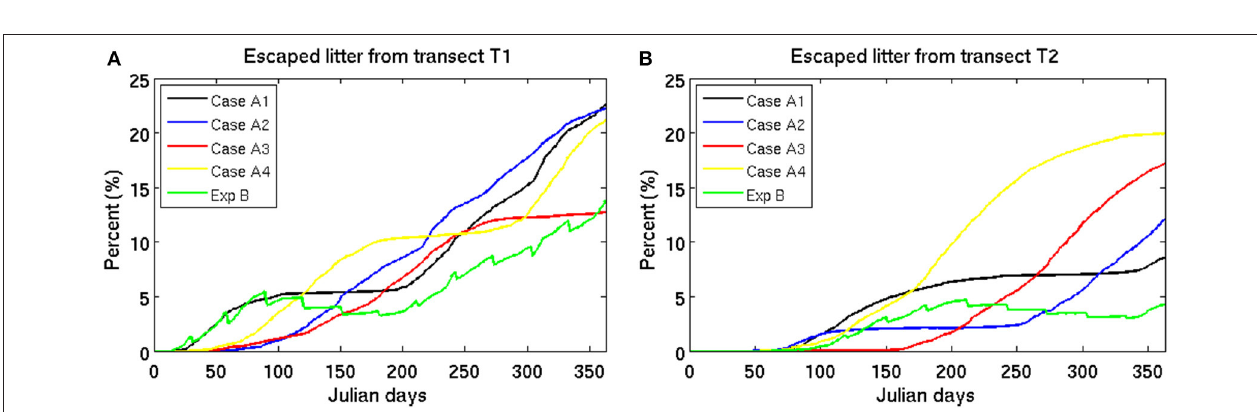
FIGURE 11 | Daily percent of escaped particles across transects (A) T1 and (B) T2 in Cases A1-A4 and Experiment B.